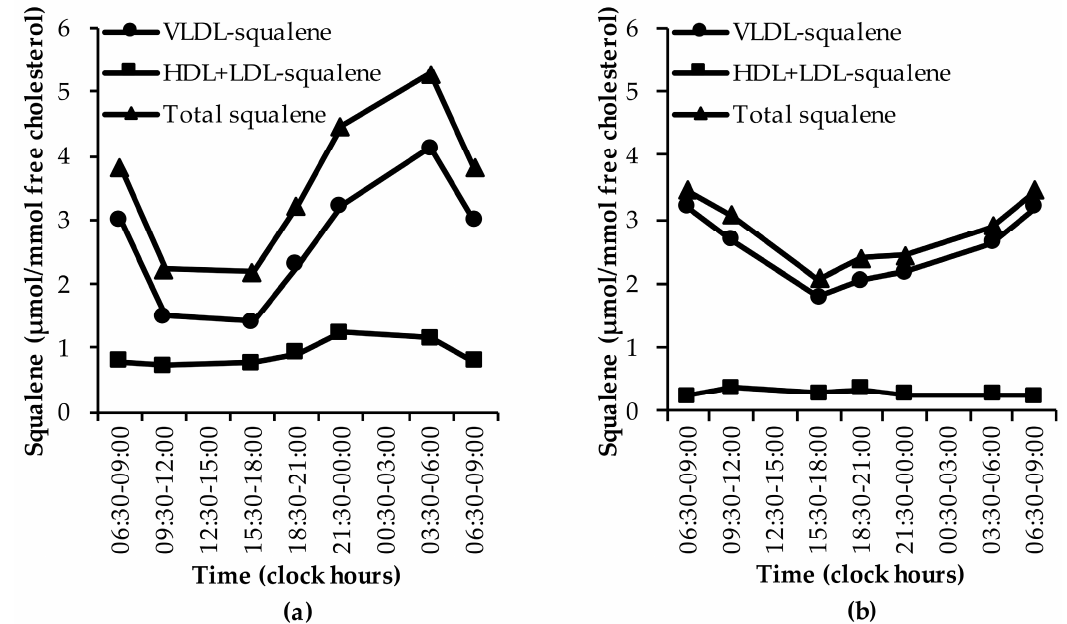
Figure 4. The diurnal rhythm of squalene levels: ( a ) in healthy subjects [29], and ( b ) in subjects with jejunoileal bypass and ileal exclusion [32]. Data are presented as medians.